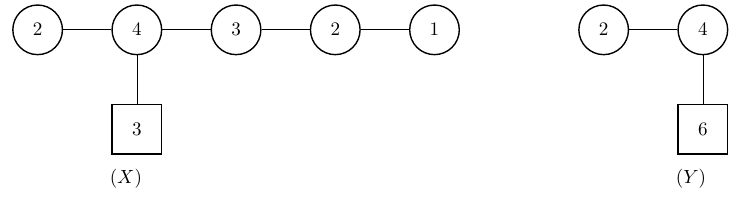
Figure 35 . A 3d mirror pair involving linear